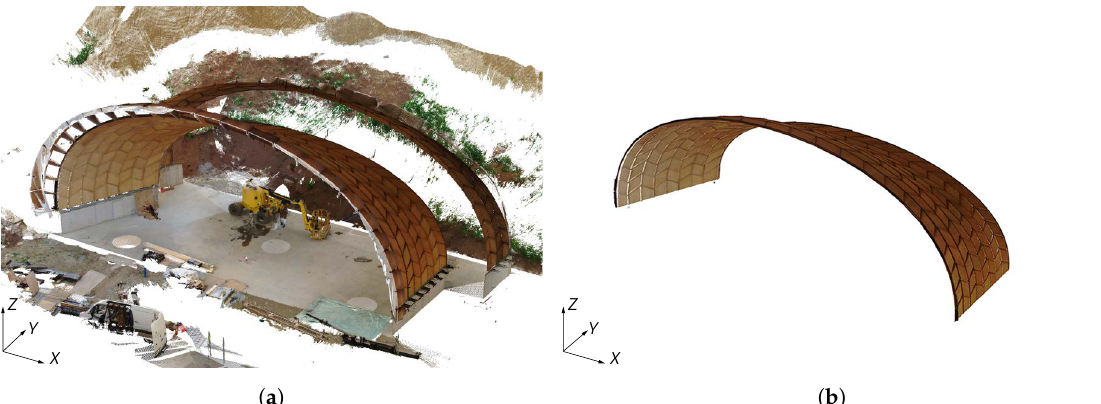
Figure 8. Pre-processing of the point clouds for Load case n° 1: ( a ) Raw point cloud; ( b ) Pre-processed point cloud reduce to 34 million points.